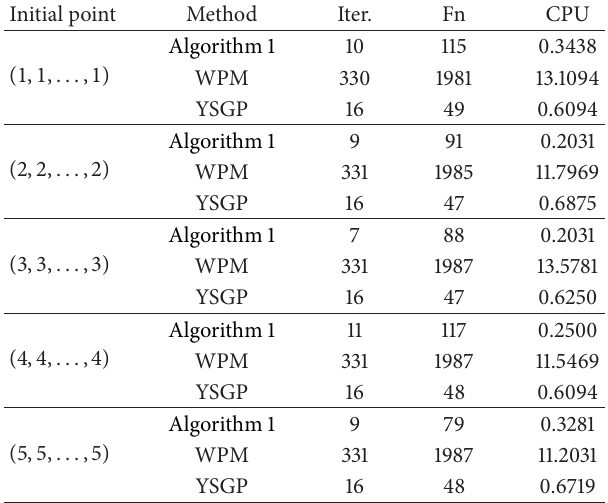
Table 2: Numerical results with different initial points of Problem 12 with 𝑛 = 64